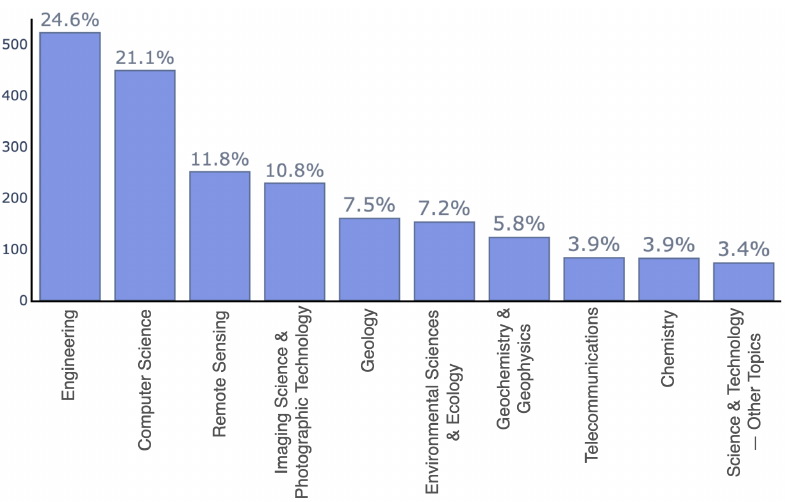
Figure 5. The top ten research areas of the filtered WoS results. The vertical axis represents the number of publications in a particular area. The percentages above the bars indicate the relative frequency of each